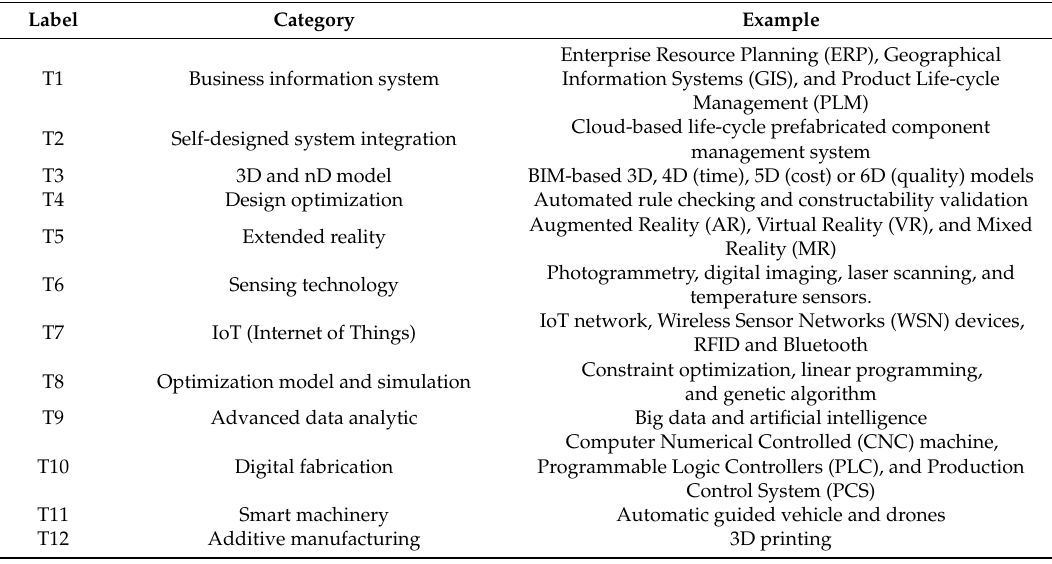
Table 1. Technology categorization.